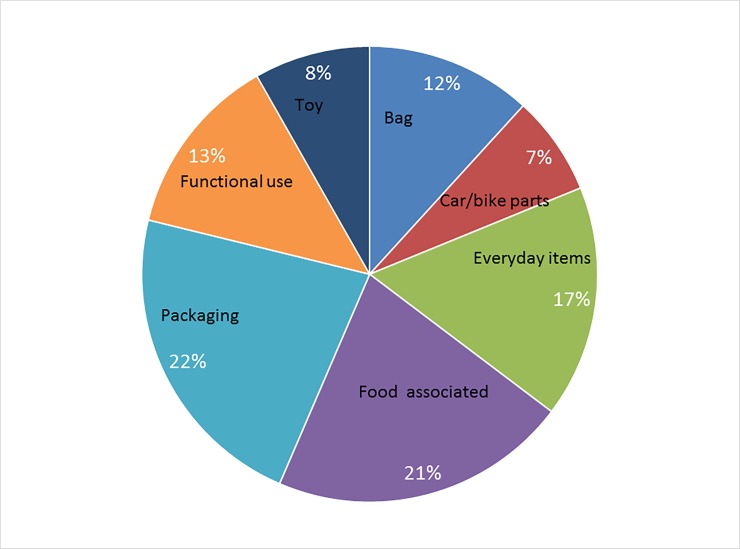
Classification of collected plastics based on original use.